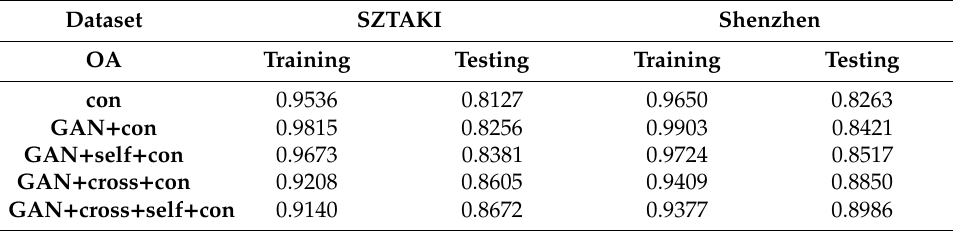
Table 4. Training and testing overall accuracy on SZTAKI and Shenzhen dataset for different losses.